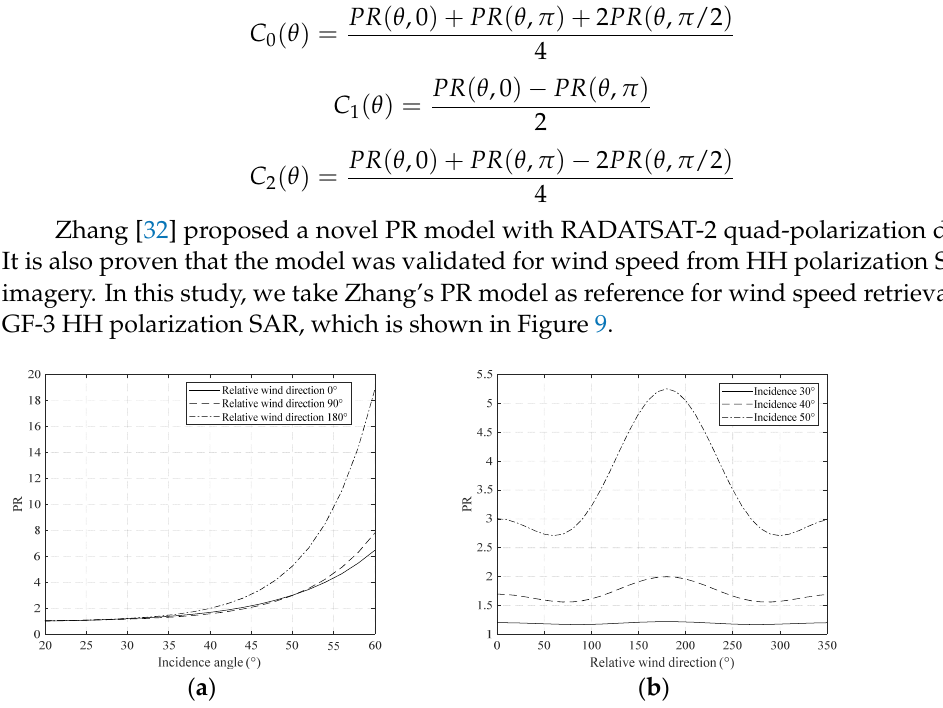
Figure 9. The PR model refitted from GF-3 SAR imagery: ( a ) Represents the PR variation relative to incidence angle; ( b ) Represents the PR variation relative to relative wind direction.